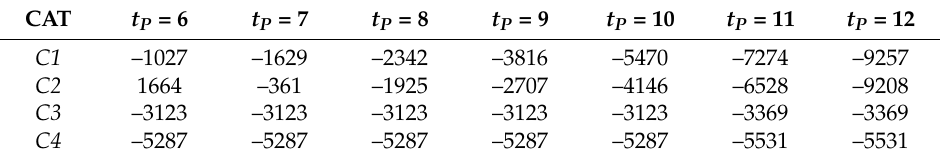
Table 3. LSE’s daily loss with contingency anticipation time in the modified six-bus test system ($).